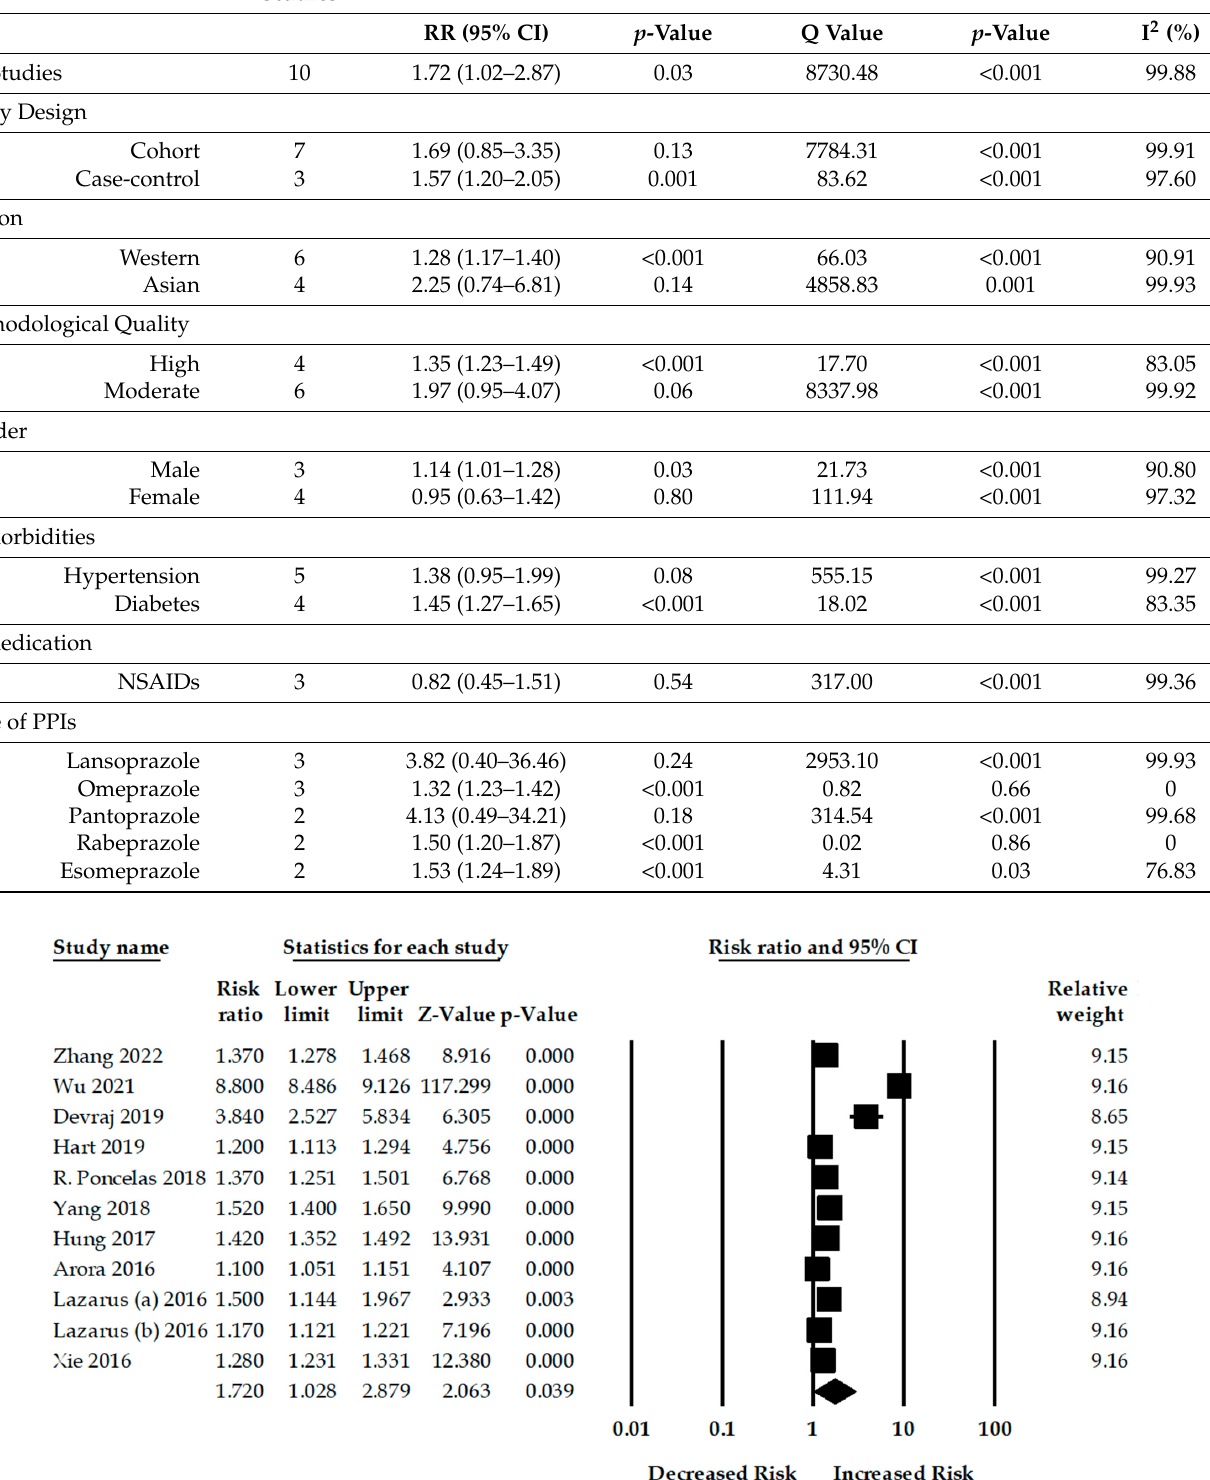
Table 2. Subgroup analysis for the association between PPI and CKD.